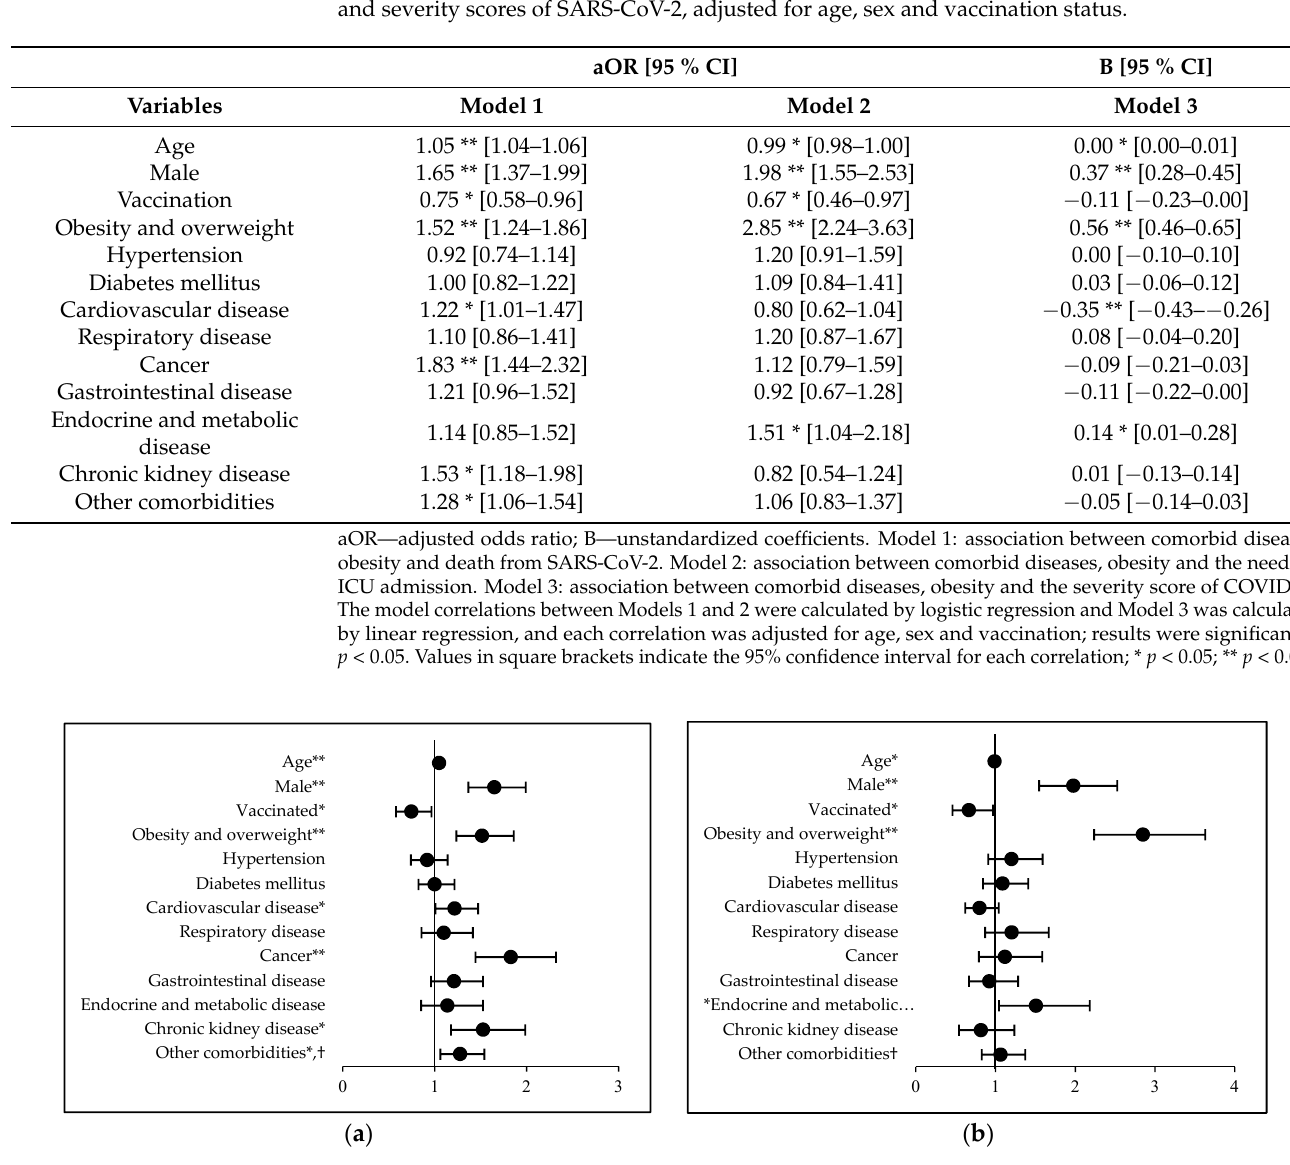
Figure 1. Forest plot graph representing the impacts of comorbidities and obesity on COVID-19- related mortality and the need for ICU treatment. ( a ) Association between comorbid diseases, obesity and death from SARS-CoV-2. ( b ) Association between comorbid diseases, obesity and the need for ICU admission. * Indicates p < 0.05 and ** indicates p < 0.01. Error bars indicate the 95% confidence interval for each correlation. † Other comorbidities: neurological and mental health conditions, hematologic diseases, autoimmune diseases, BPH and other urological disorders, rheumatological and orthopedic conditions, etc. Table 1. Associations between comorbid diseases, obesity, fatal outcome, the need for ICU admis- sion and severity scores of SARS-CoV-2, adjusted for age, sex and vaccination status.